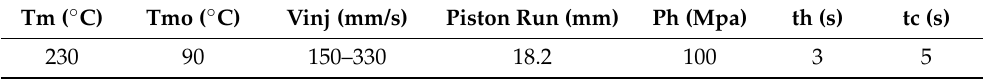
Table 3. Case A: process parameters setting.